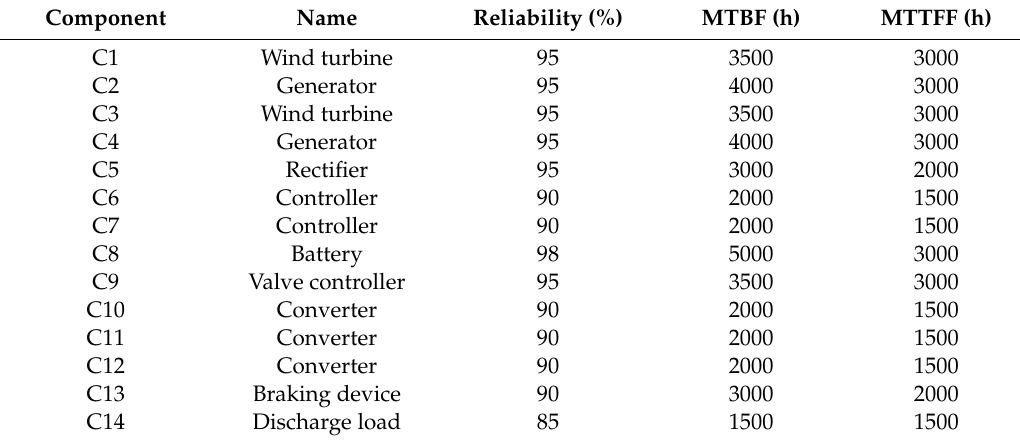
Table 7. Components’ reliability of the within prescribed time limit for security.